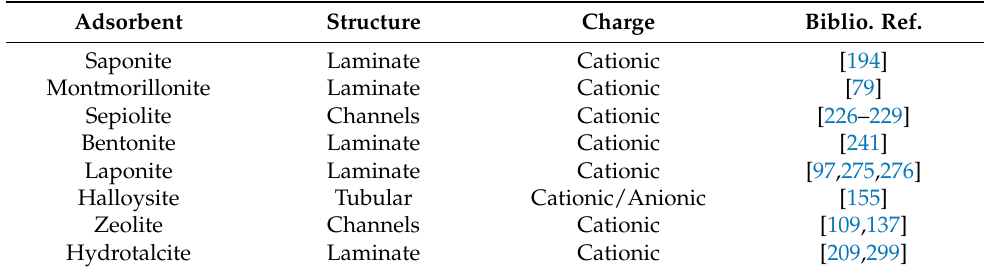
Table 3. Adsorbents’ characteristics